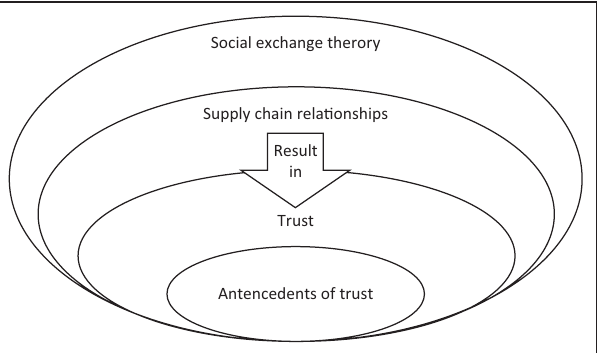
FIGURE 1: Scope of the